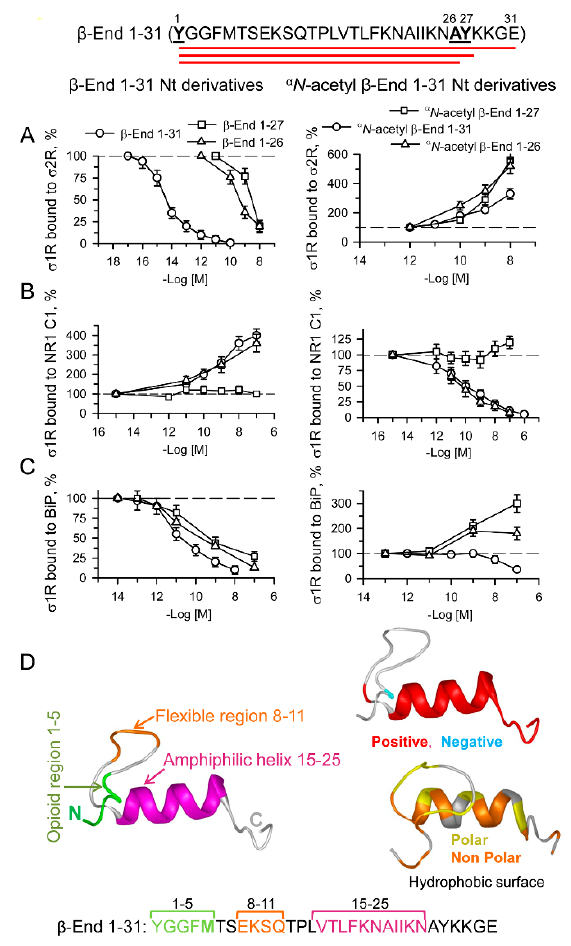
Figure 7. Effect of β -End 1–31, α N -acetyl β -End 1–31 and their N-terminal derivatives on σ 1R- σ 2R, σ 1R-NR1 C1 and σ 1R-BiP associations. Amino acid sequence of β -End 1–31 showing derivatives 1– 26 and 1–27. ( A ) HaloLink ‐ attached σ 2Rs were incubated for 30 min at RT in the presence of σ 1Rs (100 nM) in 300 μ L of 50 mM Tris ‐ HCl (pH 7.4), 0.2% CHAPS, and 2.5 mM CaCl 2 . After removing the unbound σ 1R proteins, the effects of increasing the peptide concentrations on σ 1R ‐σ 2R associations were studied. At the end of the incubation, protein complexes bound to HaloLink ‐σ 2R were obtained by centrifugation, washed three times, solubilized in 2× Laemmli buffer containing β‐ mercaptoethanol, resolved by SDS ‐ PAGE, and analyzed by Western blotting (for more details, see Section 4). This protocol was also used to assess the effect of ligands on ( B ) σ 1R ‐ NR1 C1 and ( C ) σ 1R ‐ BiP associations. Data were compared to that of the control, which was obtained in the absence of ligands. ( A – C ) Data are the mean ± SD, n = 3. ( D ) The β‐ End 1–31 structural models were predicted by Novafold (DNASTAR Lasergene protein v.17, Inc., Madison, WI, USA). Ribbon model: The 3D structure, charge distribution and hydrophobicity map of β‐ End 1–31 are shown. Positive charges are shown in red and negative charges in blue. Polar surfaces are shown in yellow, and nonpolar surfaces are shown in orange. Linear model: the opioid (1–5) and flexible region (8–11) sequences are shown in green and orange, respectively, and the amphiphilic helix (15–25) is shown in pink.